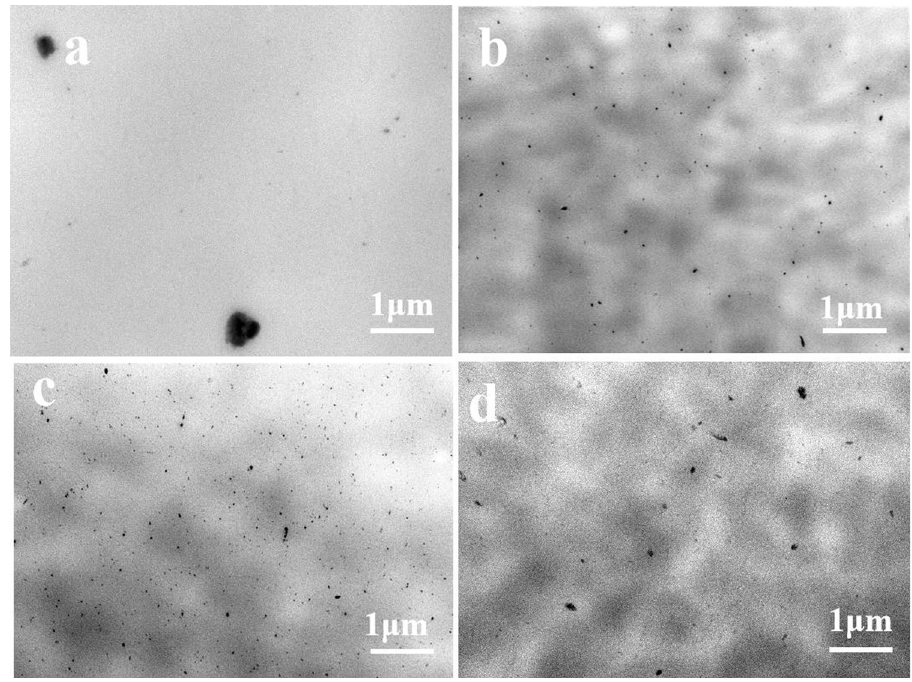
Figure 4: TEM images of ( a ) iPP/S0, ( b ) iPP/S1, ( c ) iPP/S2, and ( d )